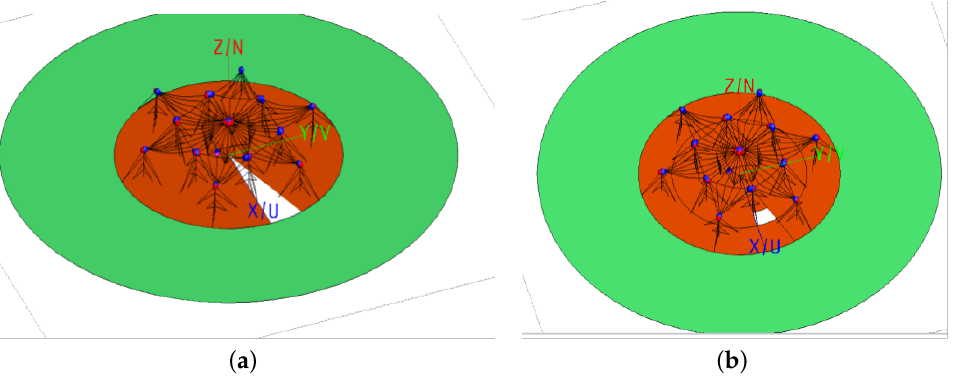
Figure 6. Schematic diagram of the second type model; the darkly colored area is the functional part of the ground network, the lightly colored area is the non-ideal ground, and the blank area is the fracture in the ground network: ( a ) The first model. ( b ) The second